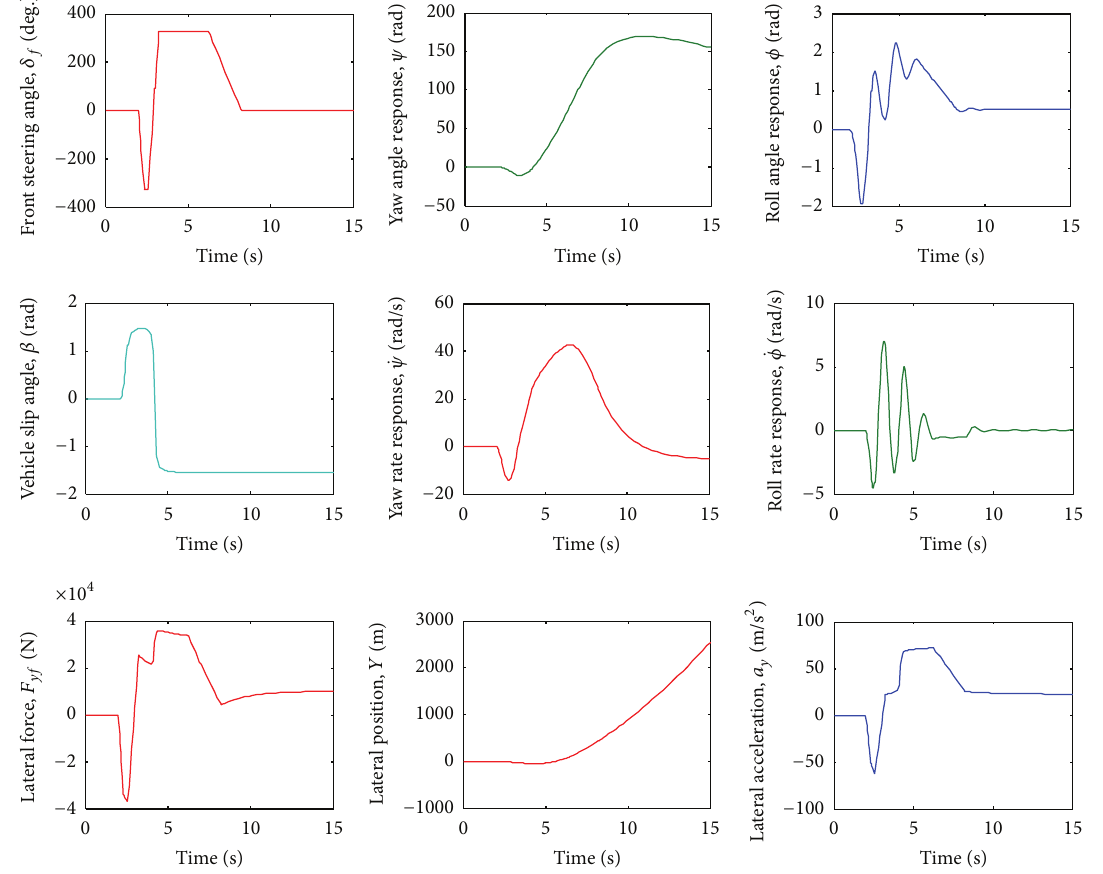
Figure 8: Vehicle manoeuvre test of roll rate feedback at 30 ms −1 with 𝜇 = 0.1 .